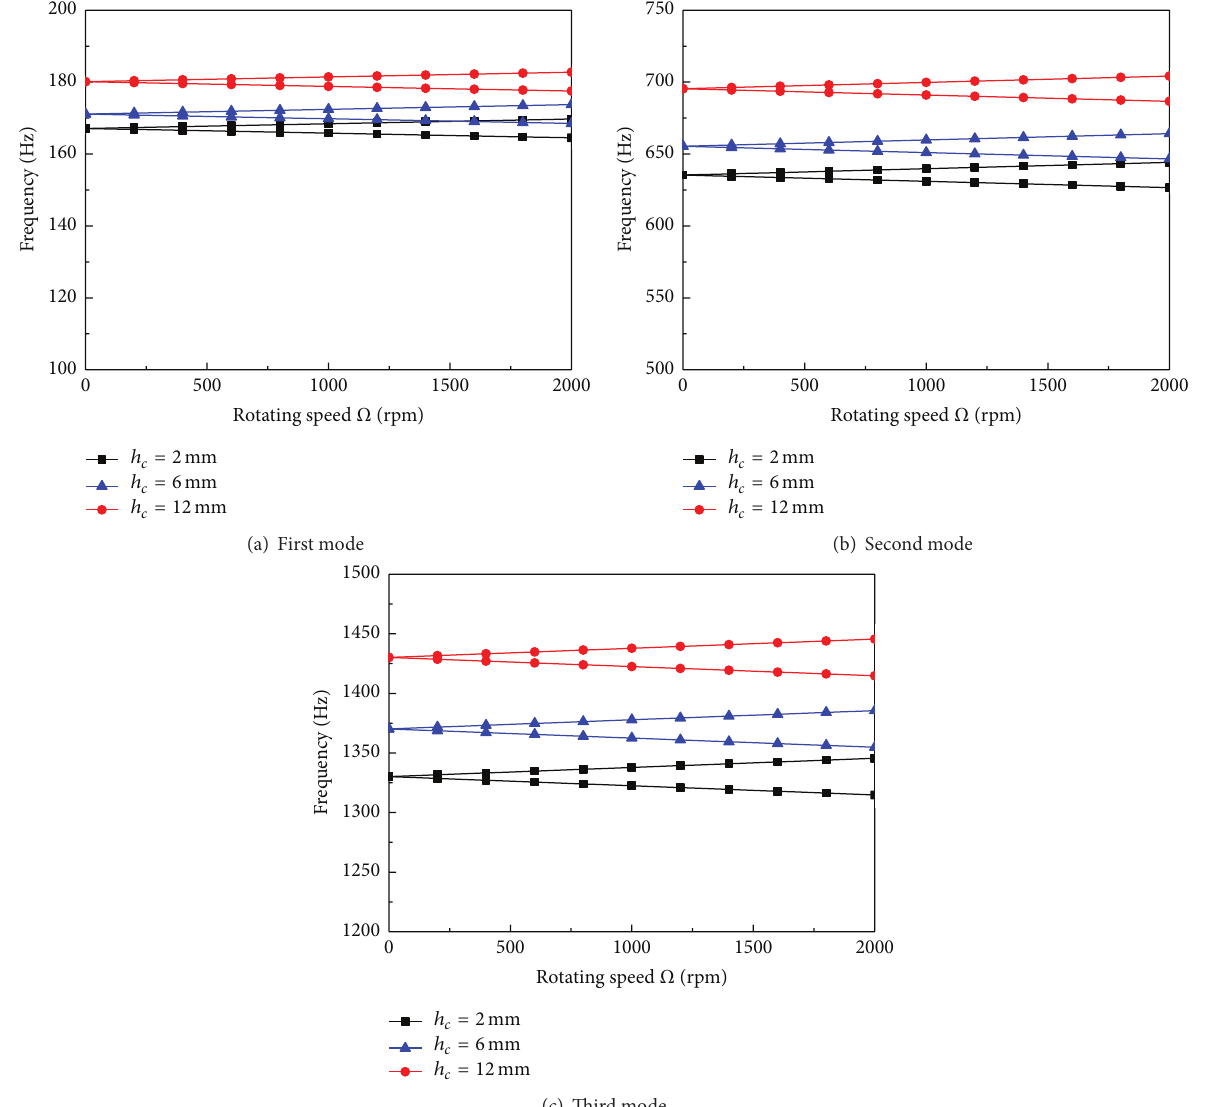
Figure 6: The first three natural frequencies versus rotating speed for various thicknesses of constraining layer ( ℎ V = 2 mm, 𝜃 = 60 ∘